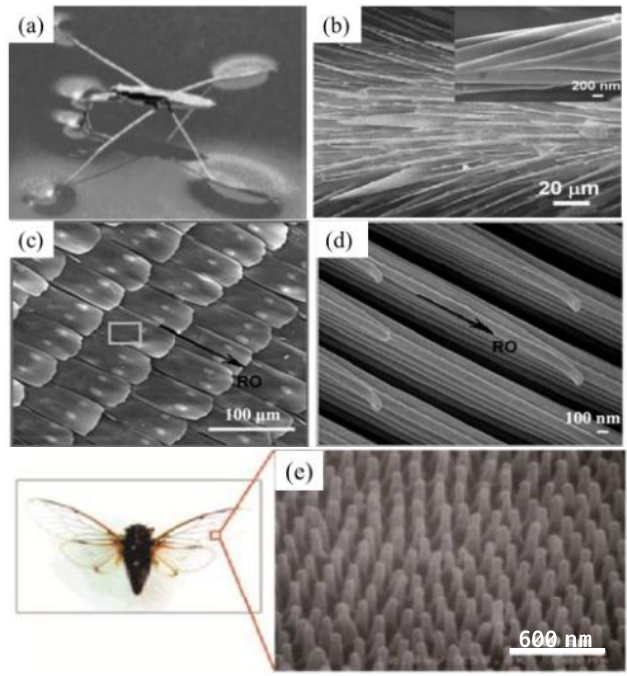
Figure 7. ( a ) Water strider walks on water [117]; reproduced with permission from Nature Publishing Group. ( b ) The micro-/nanostructure of water strider legs [117]. ( c ) The step-like butterfly wing [118] and ( d ) high-resolution microimage [118]; reproduced with permission from The Royal Society of Chemistry. ( e ) The microstructure of cicada wings [121]; reproduced with permission from IOP Science.